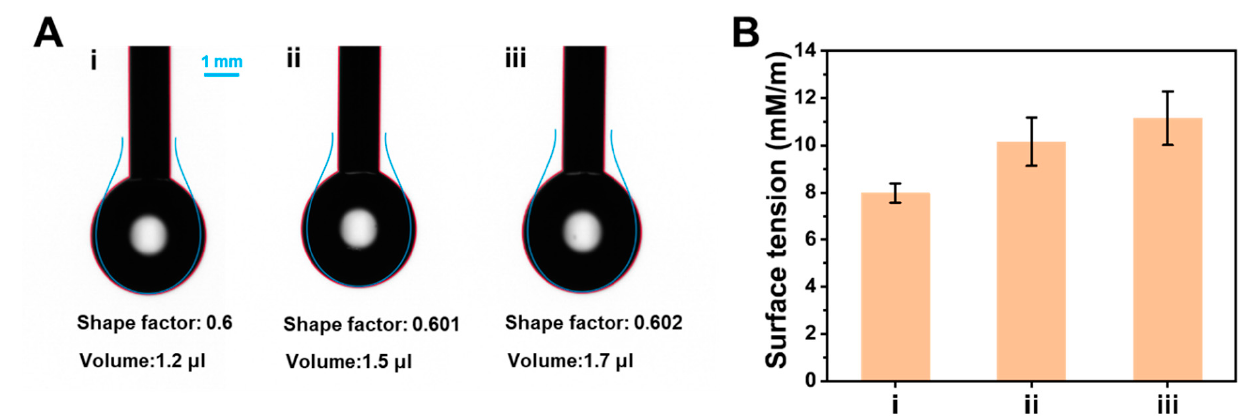
Figure 7. ( A ) Dropping photos and ( B ) corresponding surface tension of different solutions: (i) BSA, (ii) BSA + low concentration of AA (200 µ mol L − 1 ), (iii) BSA + high concentration of AA (400 µ mol L − 1 ).